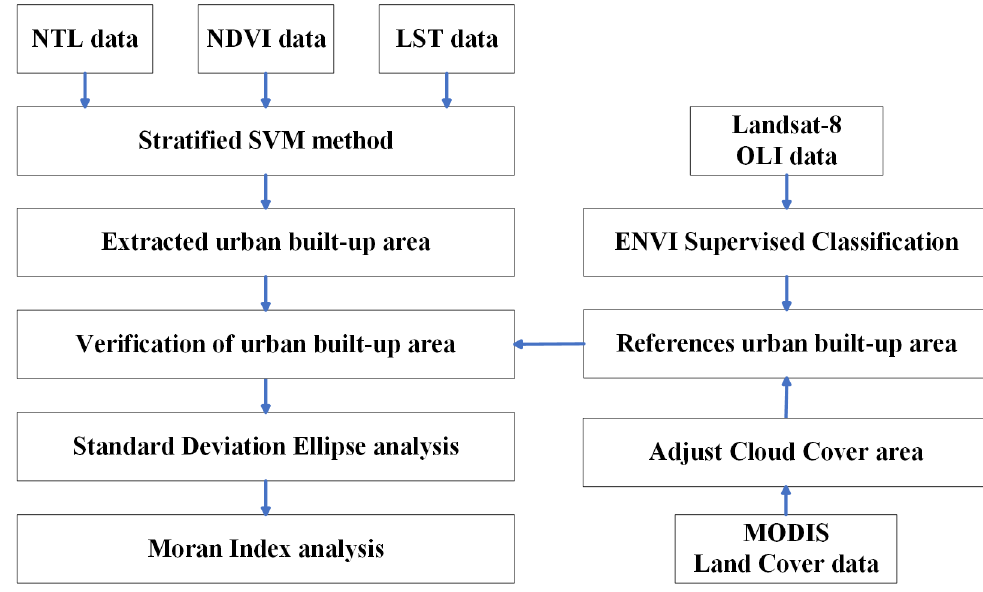
Figure 3. The flowchart of the proposed